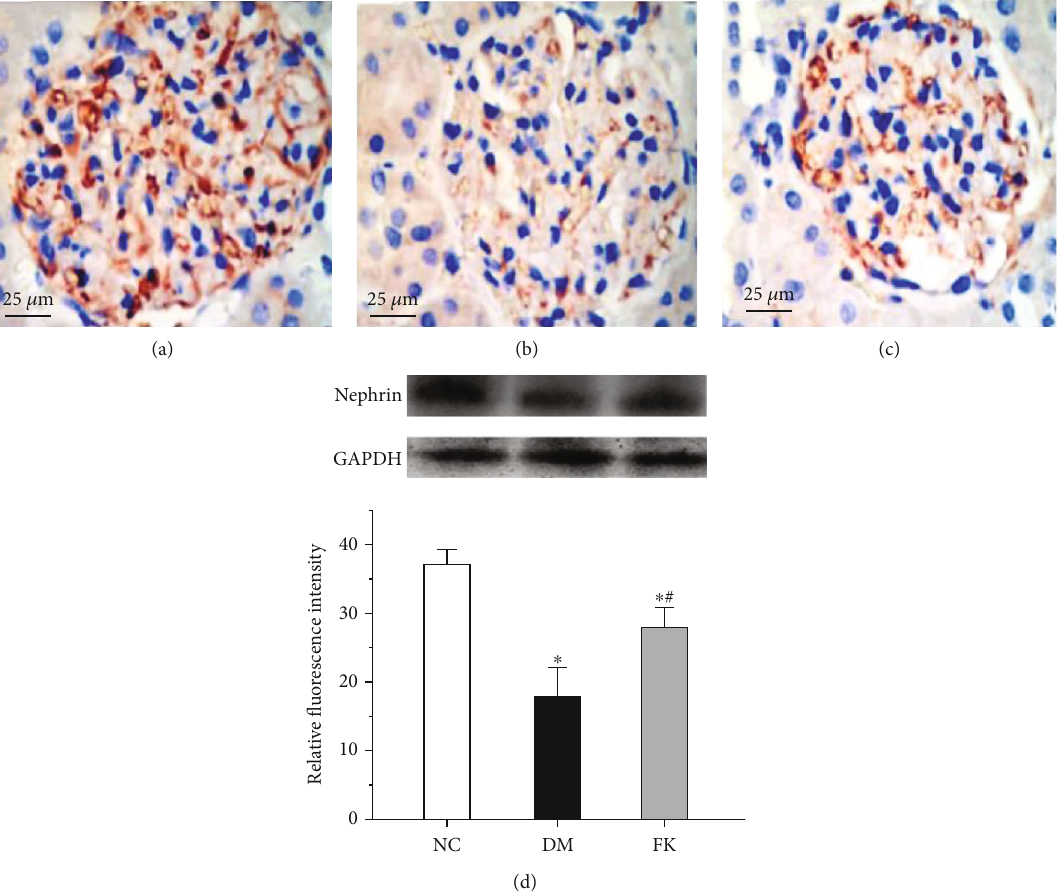
Figure 4: Podocyte-speci fi c nephrin expressions detected by immunohistochemistry. Nephrin distribution patterns were observed in the (a) NC group, (b) DM group, and (c) FK group. (d) Western blot and quanti fi cation of nephrin integral values in each group. ∗ P < 0 : 05 compared to the NC group, ∗ # P < 0 : 05 compared to the DM